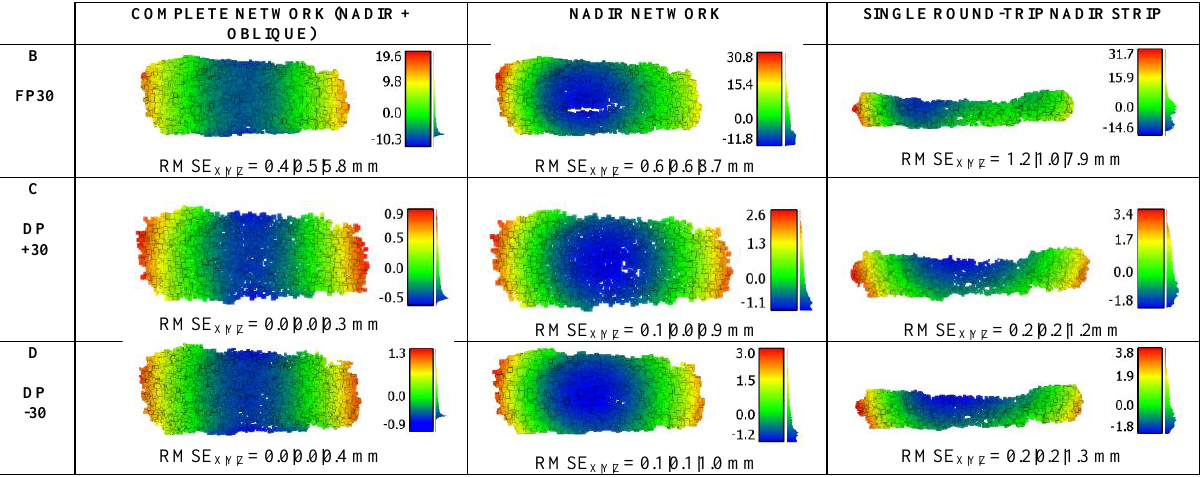
Figure 4. Color coded error maps for the tie points for the datasets B, C, D. The maps show the error in Z (the most affected) between the computed elevations derived from bundle adjustment and the correct ones (used as input for the simulations). COMPLETE NETWORK (NADIR + NADIR NETWORK SINGLE ROUND-TRIP NADIR STRIP OBLIQUE)